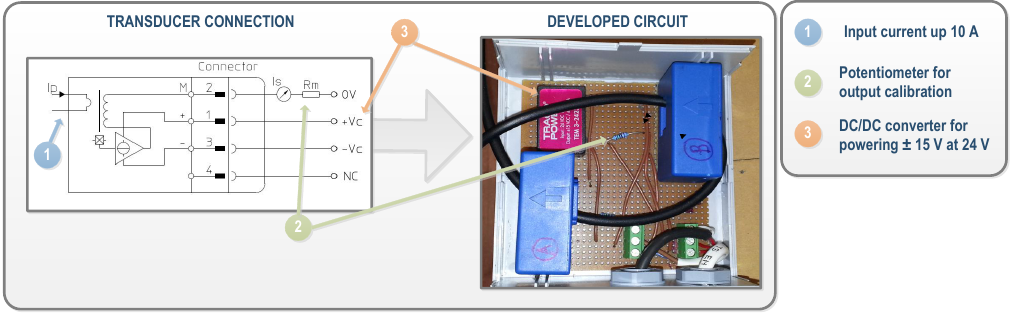
Figure 9. Conditioning of the current transducers for measuring the DC currents generated by the solar trackers.